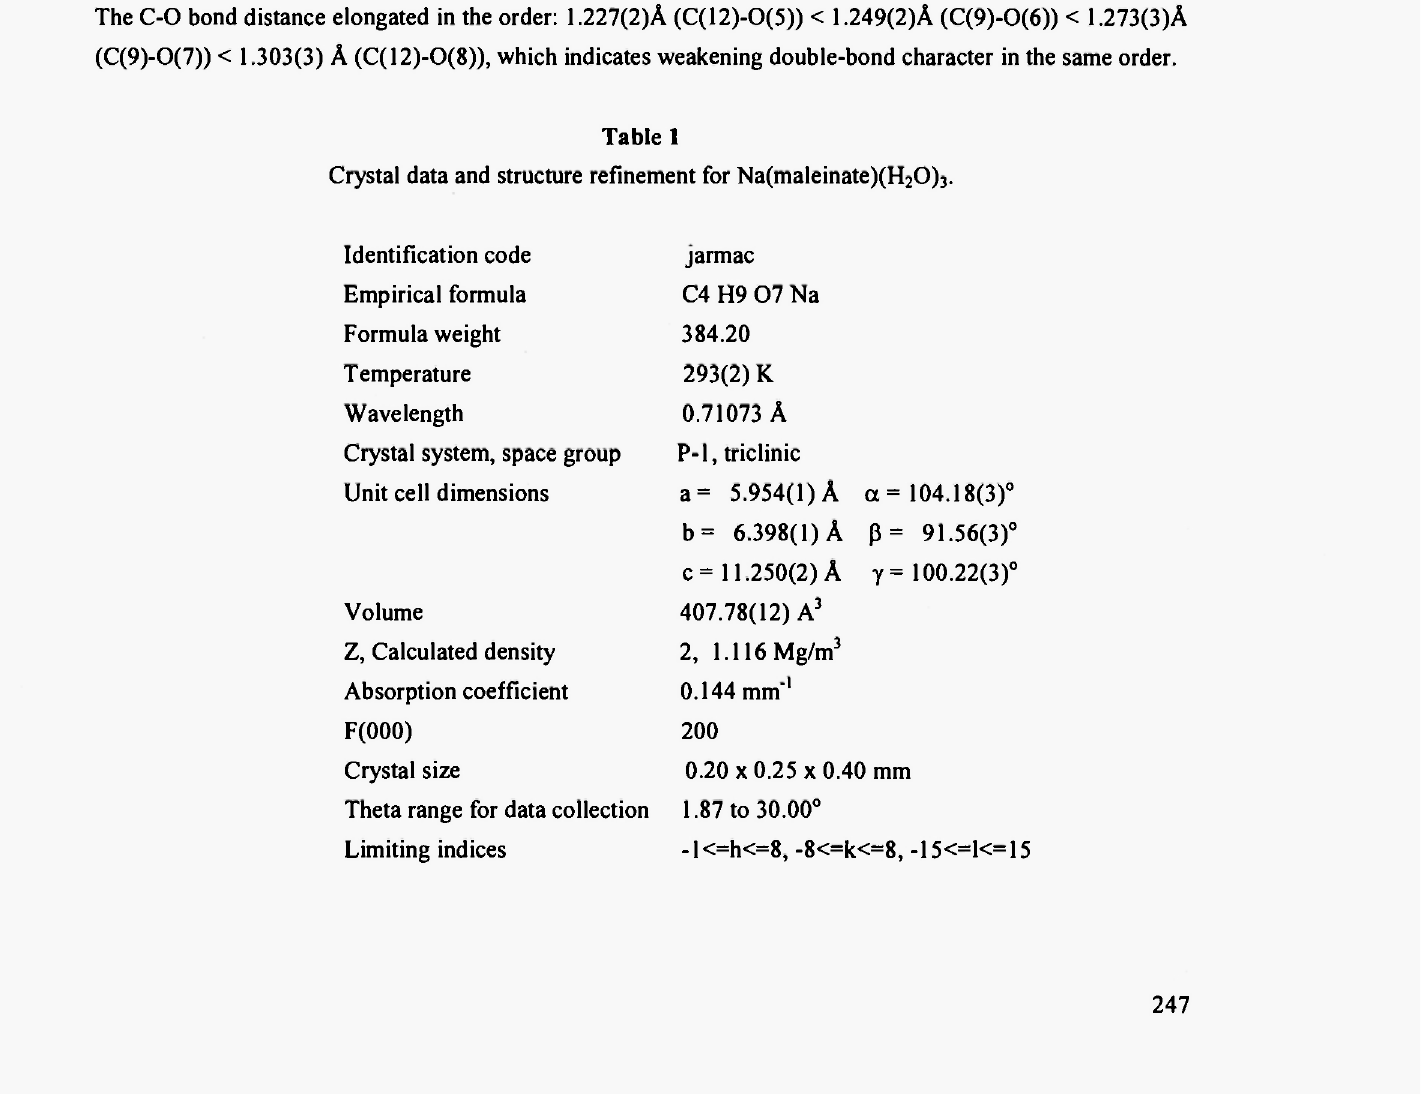
Crystal data and structure refinement for Na(maleinate)(H 2